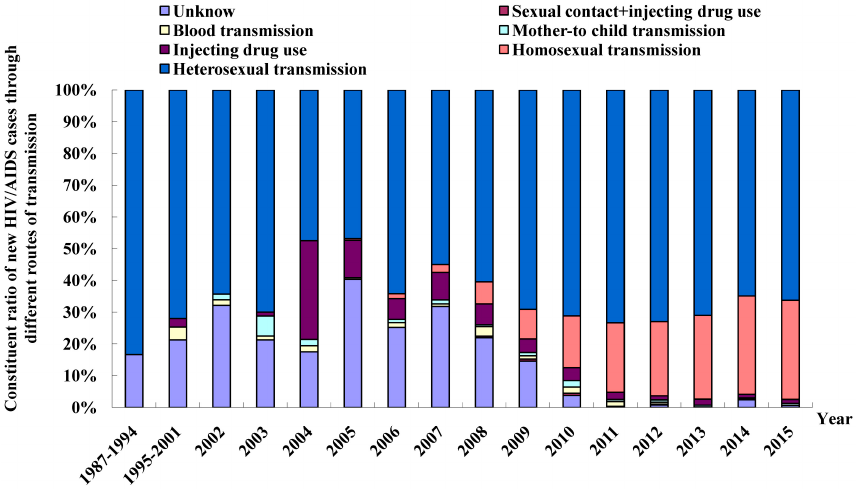
Figure 8. Routes of transmission of new HIV/AIDS cases in Fujian Province from 1987 to 2015.